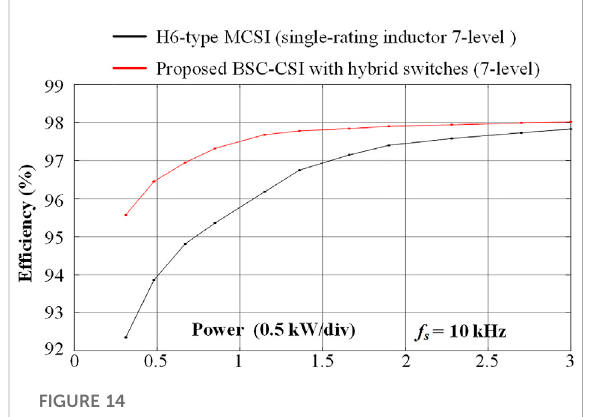
Ef fi ciency comparison of the two experimental